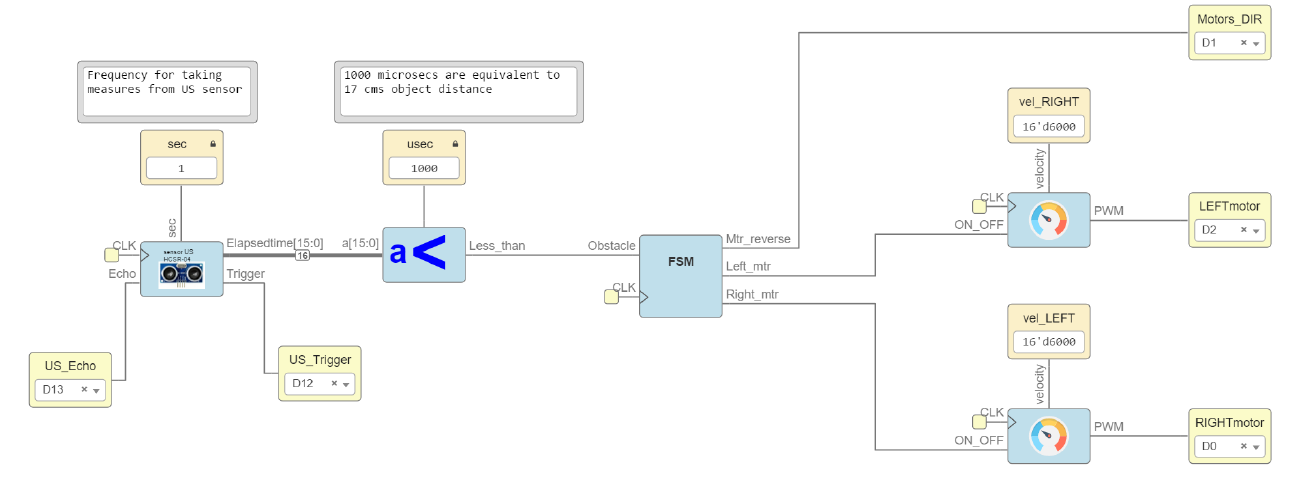
Figure 8. IceStudio circuit for obstacle avoidance behavior.